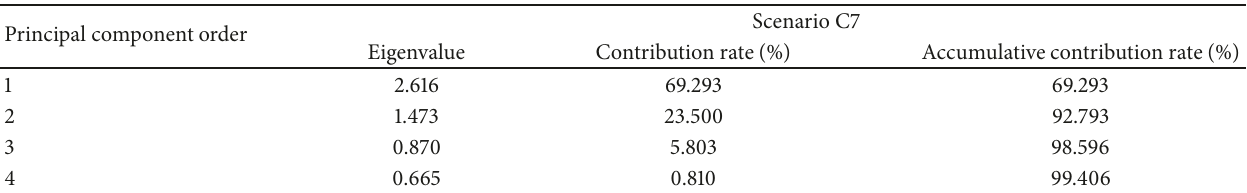
Table 2: Analysis results of PCA for 𝑇 2 6 corresponding to damage scenario